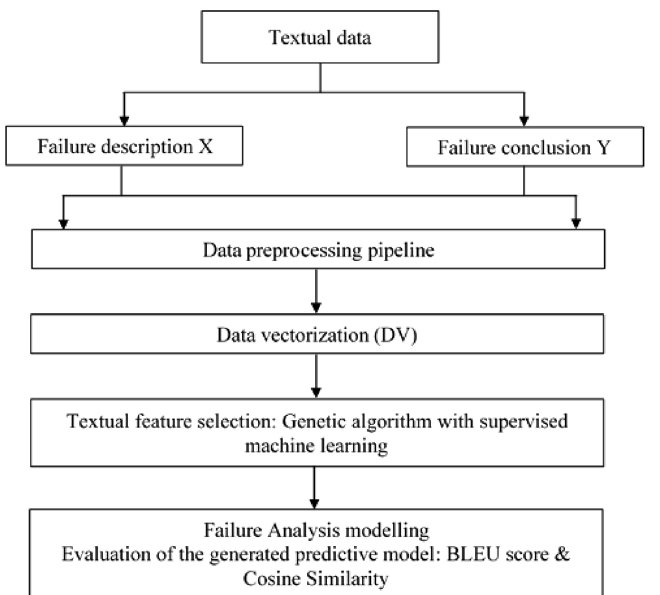
Figure 2. Synoptic representation of the proposed GA methodology.